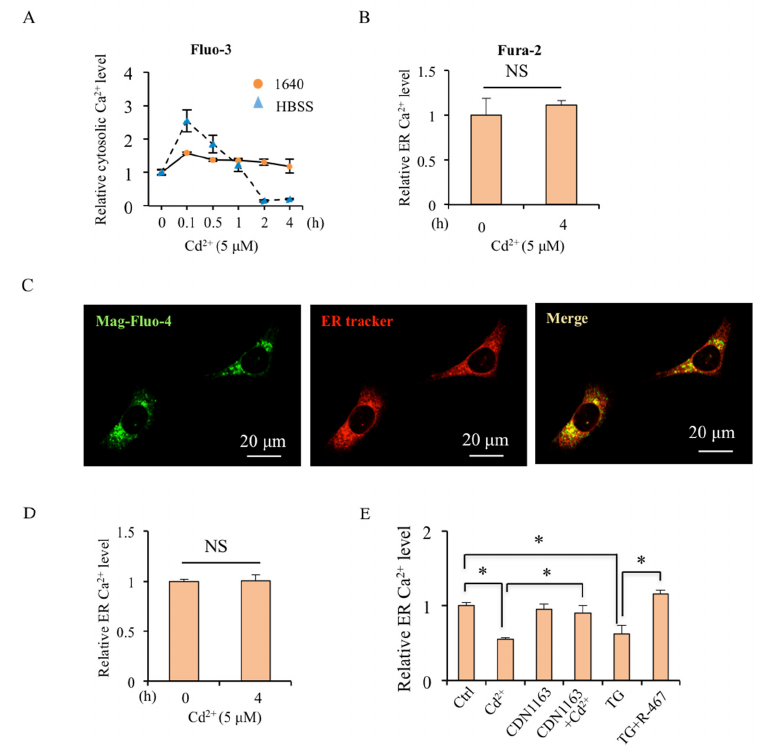
Figure 2. Effects of ER Ca 2+ channels in Cd 2+ -dysregulated ER Ca 2+ homeostasis. ( A ) Short-term effects of Cd 2+ on cytosolic Ca 2+ content in mRTEC cells. Cells were treated with CdCl 2 (5 µ M) for 0–4 h, and the cytosolic Ca 2+ levels in mRTEC cells were determined by Fluo-3/AM in Ca 2+ containing and Ca 2+ -free medium, respectively. ( B ) Steady cytosolic Ca 2+ levels in mRTEC cells were determined by Fura-2/AM after being treated with CdCl 2 (5 μ M) for 4 h. ( C ) Co-localization of ER Ca 2+ content indicator Mag-Fluo-4/AM staining (Green) with ER tracker (Red). ( D ) Effects of short-term Cd 2+ treatment on ER Ca 2+ content. After being treated with Cd 2+ (5 μ M) for 4 h, the ER Ca 2+ content in mRTEC cells was determined by Mag-Fluo-4/AM. ( E ) Effects of SERCA modulators on Cd 2+ -regulated ER Ca 2+ content in mRTEC cells. After being treated with Cd 2+ (5 μ M) for 24 h or pretreated with CDN1163 (10 μ M) or R-467 (1 μ M) for 1 h, followed with TG (0.1 μ M) for 6 h. The ER Ca 2+ content in mRTEC cells was determined by Mag-Fluo-4/AM. Results are presented as mean ± SD ( n = 4 well cells/group). * Statistical significance difference between control and Cd 2+ treatment or between treatments. NS—No significant difference. p < 0.05, using one-way ANOVA followed by Duncan’s multiple range test. CDN1163: agonist of ER Ca 2+ reuptake channel SERCA, TG: inhibitor of SERCA.